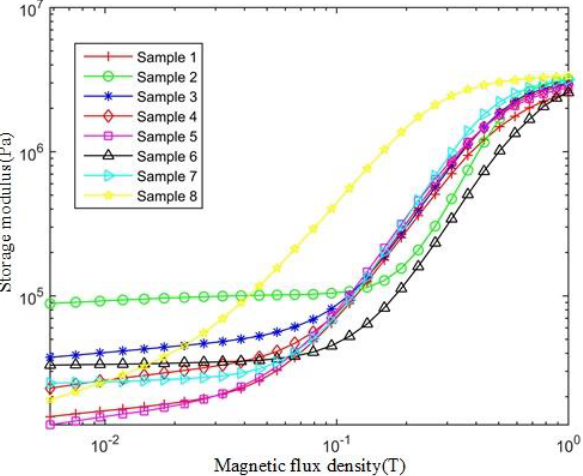
Figure 7. Relationship between storage modulus and magnetic flux density with a fixed shear strain of 0.1%. of 0.1%.